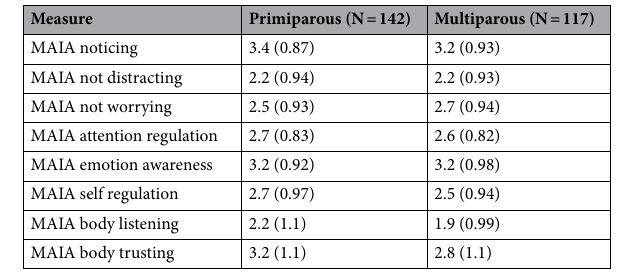
Table 6. Means (SD) of primiparous and multiparous women for the MAIA subscales. Higher scores indicate higher levels of awareness. MAIA multidimensional assessment of interoceptive